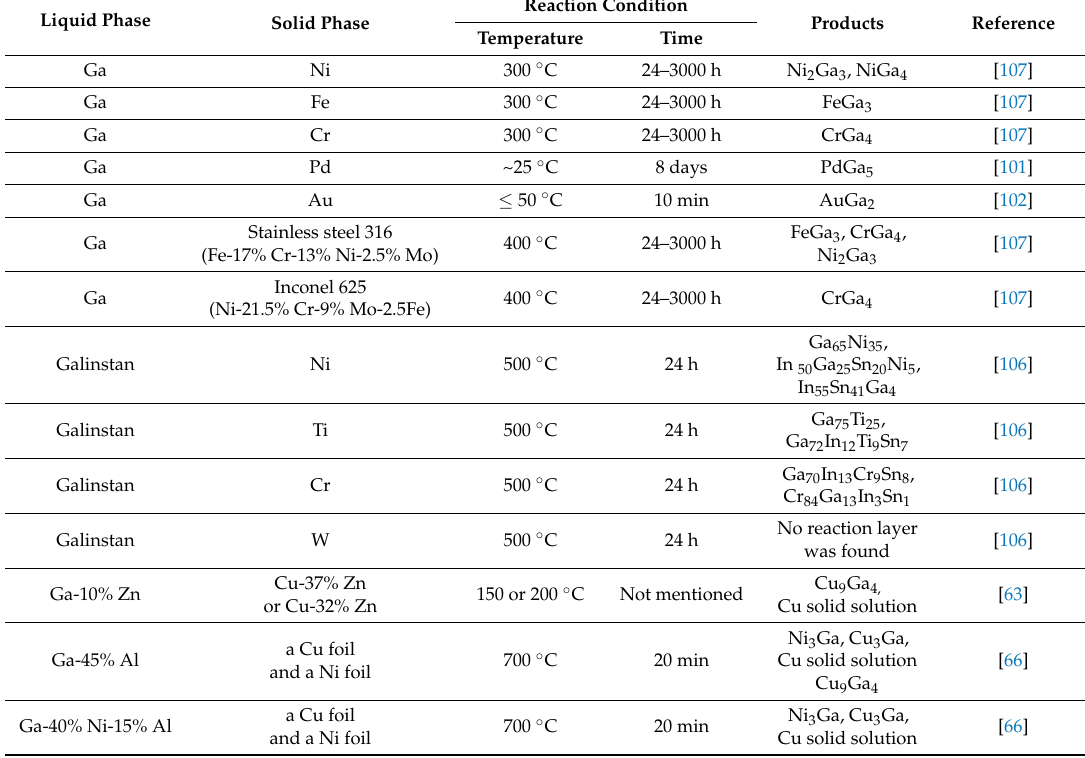
Table 5. Summary of reactions between liquid Ga-based alloys and substrates other than